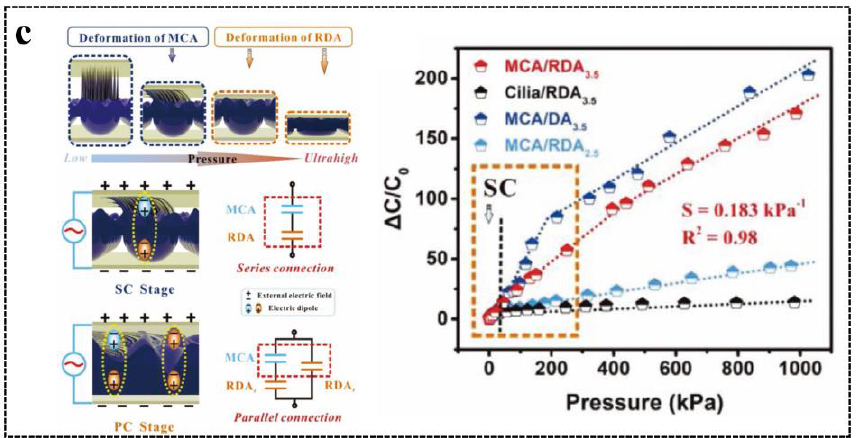
Figure 2. Strategies of tactile and force sensors used to increase the linear detection range: ( a ) Illustration of the trade–off between sensitivity and linear detection range. Reproduced with permission [10], Copyright 2020, American Chemical Society. ( b ) A multilayered ferroelectric sensor that has a larger linear detection range than single and double–layer sensors. Reproduced with permission [86], Copyright 2018, American Chemical Society. ( c ) A hybrid dielectric for capacitive and triboelectric sensors that has an MPa linear detection range. Reproduced with permission [85], Copyright 2021,